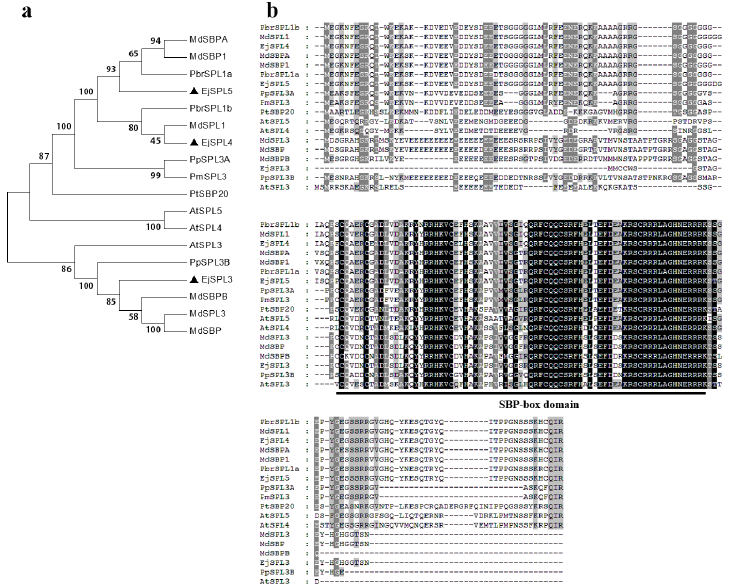
Figure 1. Sequence analysis of SPL3, SPL4, and SPL5 from various species. ( a ) Phylogenetic trees of SPL3, SPL4, and SPL5 in different species. Black triangles indicate loquat EjSPL3, EjSPL4, and EjSPL5. ( b ) Amino acid sequence alignment of SPL3, SPL4, and SPL5. Amino acids with